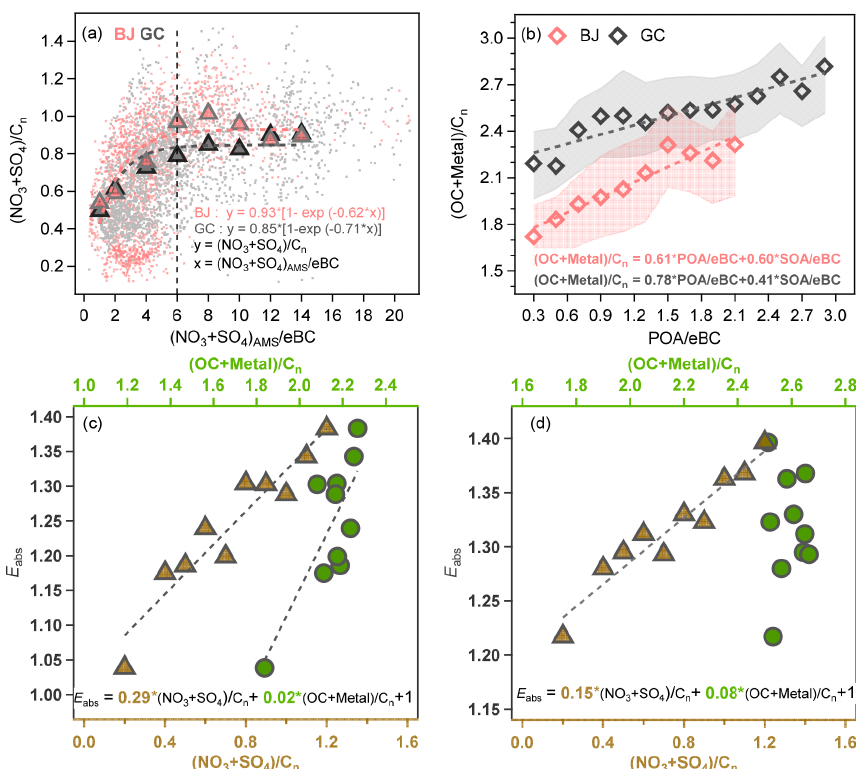
Figure 4. Relationships between peak area ratios and mass concentration ratios (a) (NO 3 + SO 4 ) / C n vs. (NO 3 + SO 4 ) AMS / eBC and (b) (OC + Metal) / C n vs. POA / eBC. Relationships between E abs and peak area ratios of coating materials (NO 3 + SO 4 ) / C n and (OC + Metal) / C n in (c) Beijing and (d) Gucheng. The triangles in (a) are the averages of different bins grouped according to (NO 3 + SO 4 ) AMS / eBC. The rhombuses in (b) are the averages of different bins that are grouped according to POA / eBC. The shaded areas in (b) indicate the 25th and 75th percentiles of the (OC + Metal) / C n ratios. The triangles and circles in (c) and (d) are the averages of different bins grouped according to (NO 3 + SO 4 ) / C n